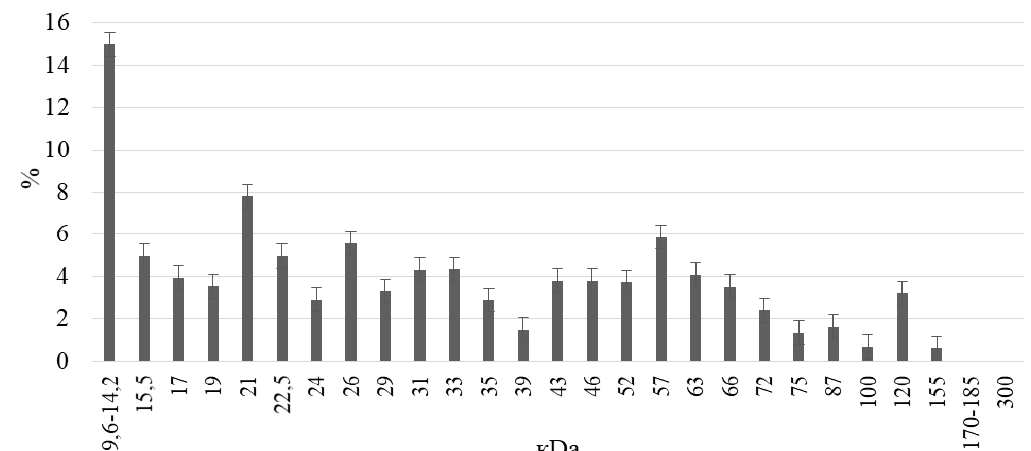
Fig. 4. Structural proteins of the basolateral membrane of the jejunum enterocytes of five-month-old cattle fetus (M ± m; %; n = 6)